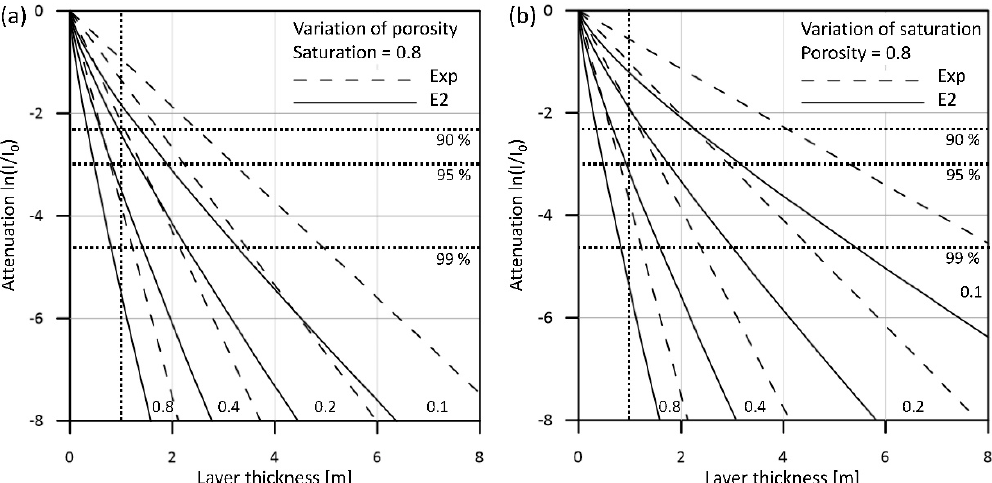
Figure 9. Attenuation I / I 0 as a function of peat layer thickness (log-lin scale) calculated for ( a ) various porosities, and ( b ) water saturations using exponential and E2 functions. The vertical dotted black line indicates the peat thickness of 1 m and the horizontal black lines indicate the 90%, 95%, and 99% attenuation.